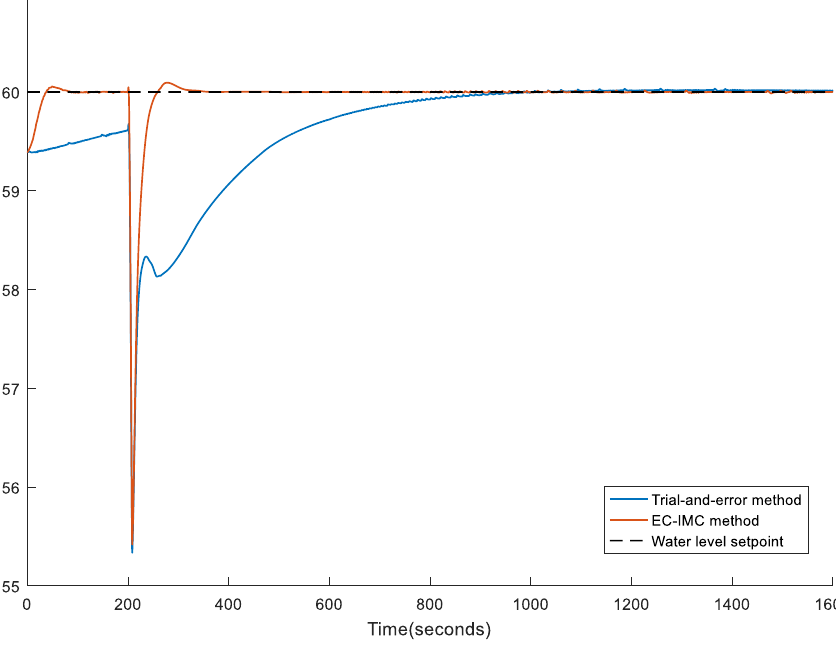
Figure 18. Water level response of power level step change from 100% to 90%.